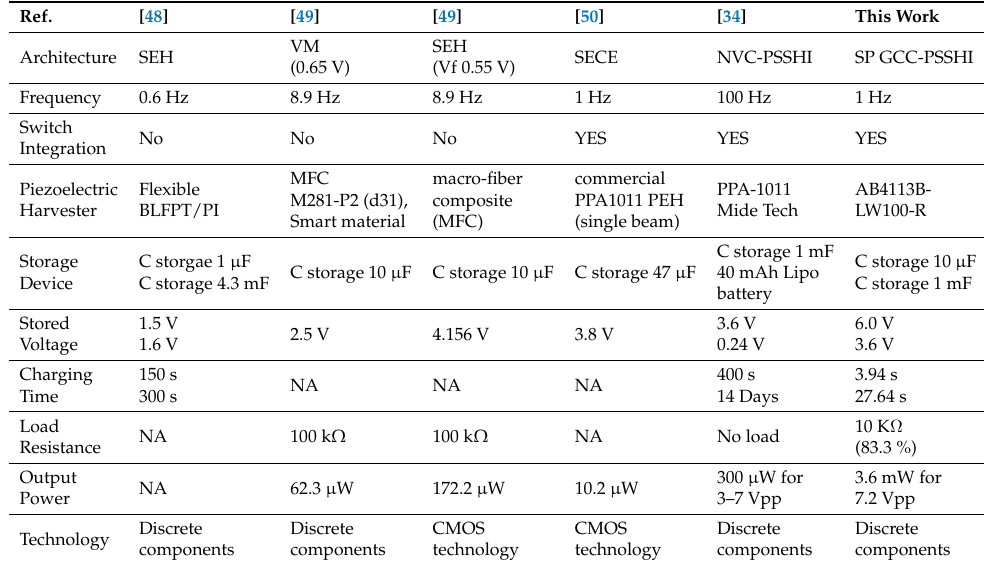
Table 5. Comparaison of the proposed SP PSSHI Circuit with State of the art solutions